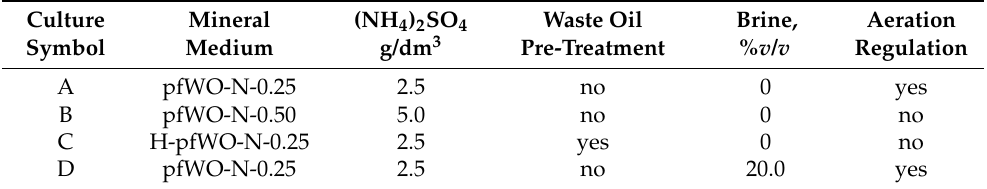
Table 1. Media and culture conditions in bioreactor